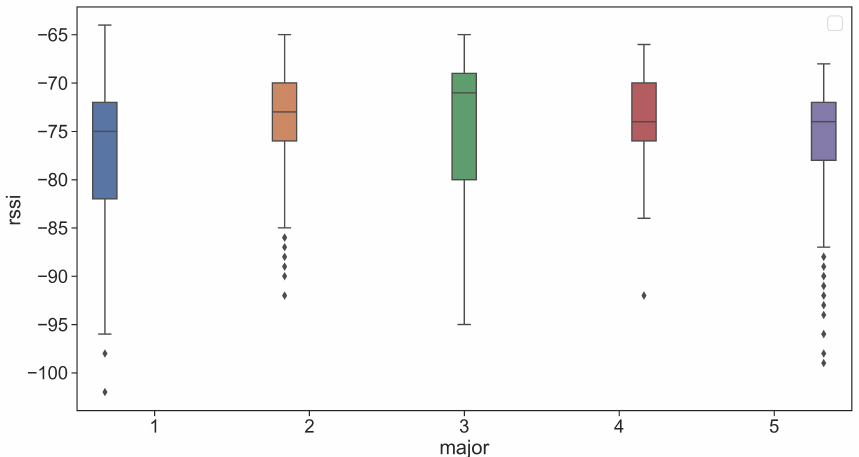
Figure 11. Box plots of the beacon’s RSS distribution for T 8